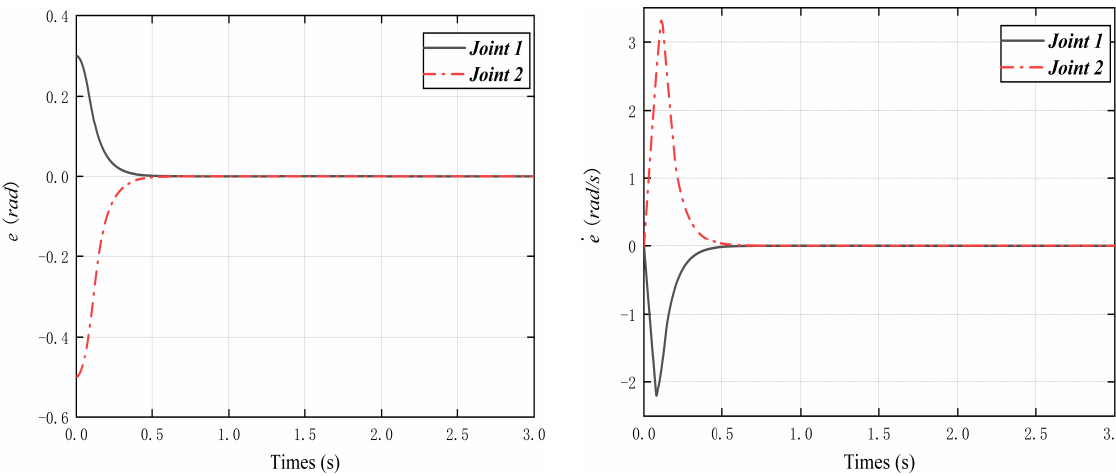
Figure 6. Position tracking error and velocity tracking error of Joint 1 and Joint 2.